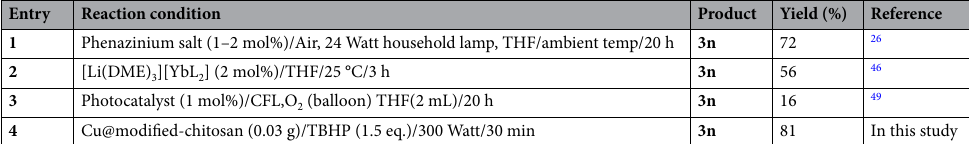
Table 6. Comparison of the catalytic activity of Cu@Sal-CS with other similar catalysts reported in the literature for preparation of amids.